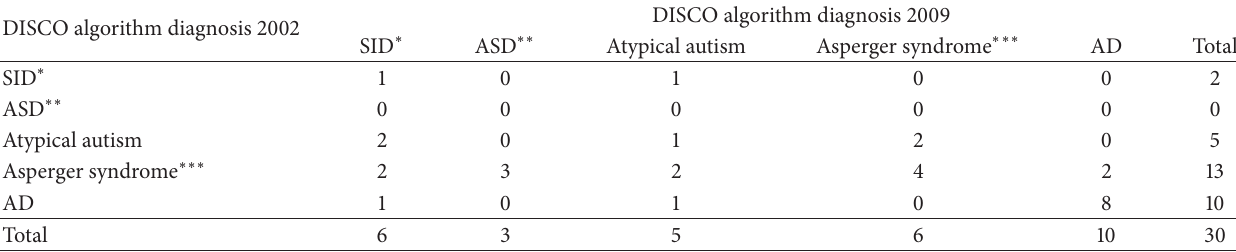
∗ Social interaction disorder according to Wing and Gould criteria. ∗∗ Autism spectrum disorder according to Wing and Gould criteria. ∗∗∗ Asperger syndrome according to Gillberg and Gillberg criteria.